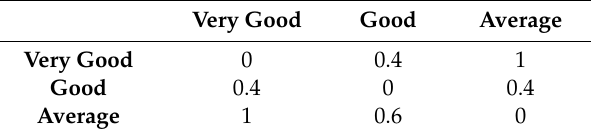
Table 4. Comparison criterion for feature “teacher”.